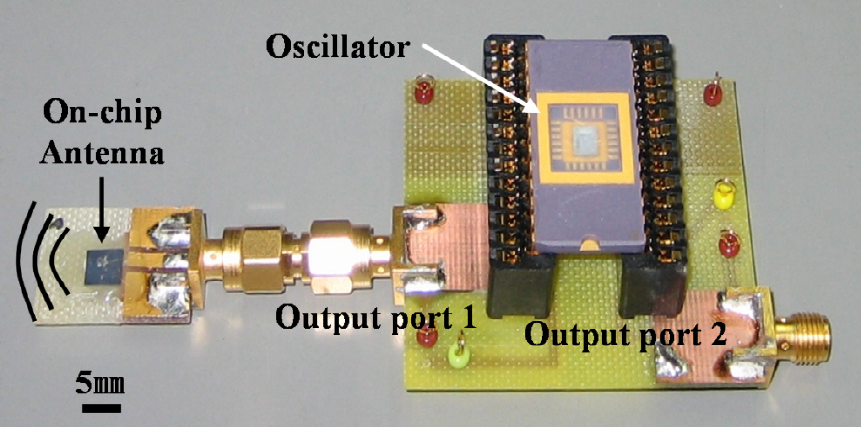
Figure 10. The configuration of measurement system for transmission